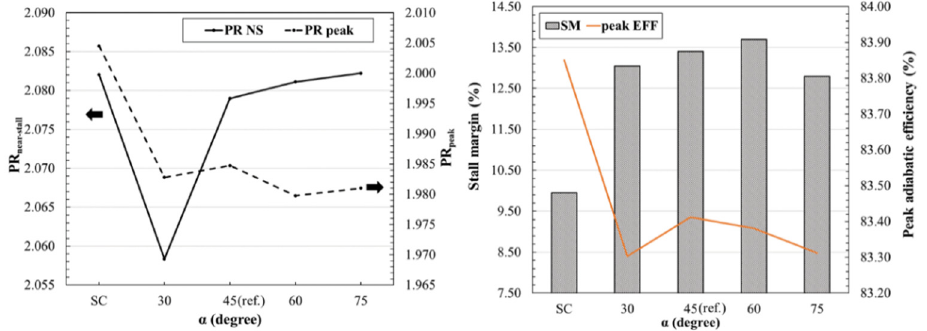
Figure 11. Effects of injection angle on performance.